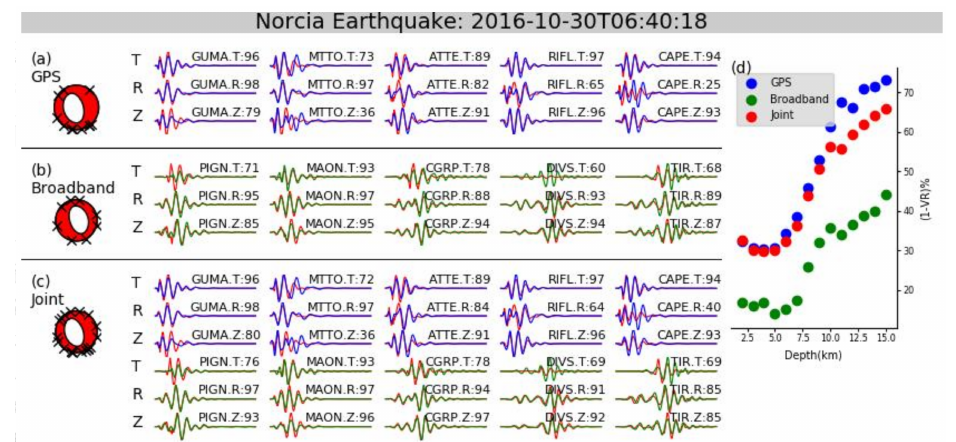
Figure 6. Inversion results of the Norcia Earthquake. The representing scheme of the subplots is the same as Figure